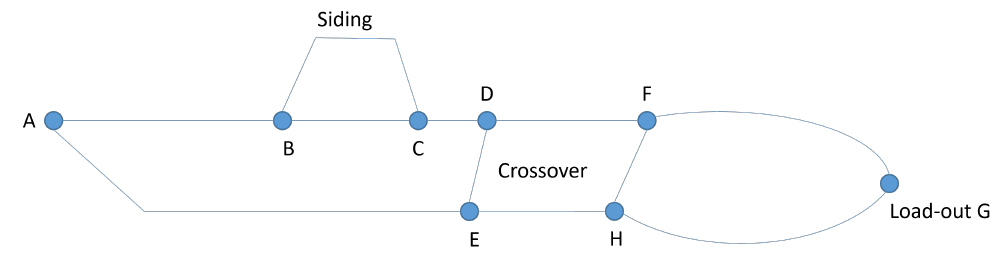
Figure 1. Railway network sample.